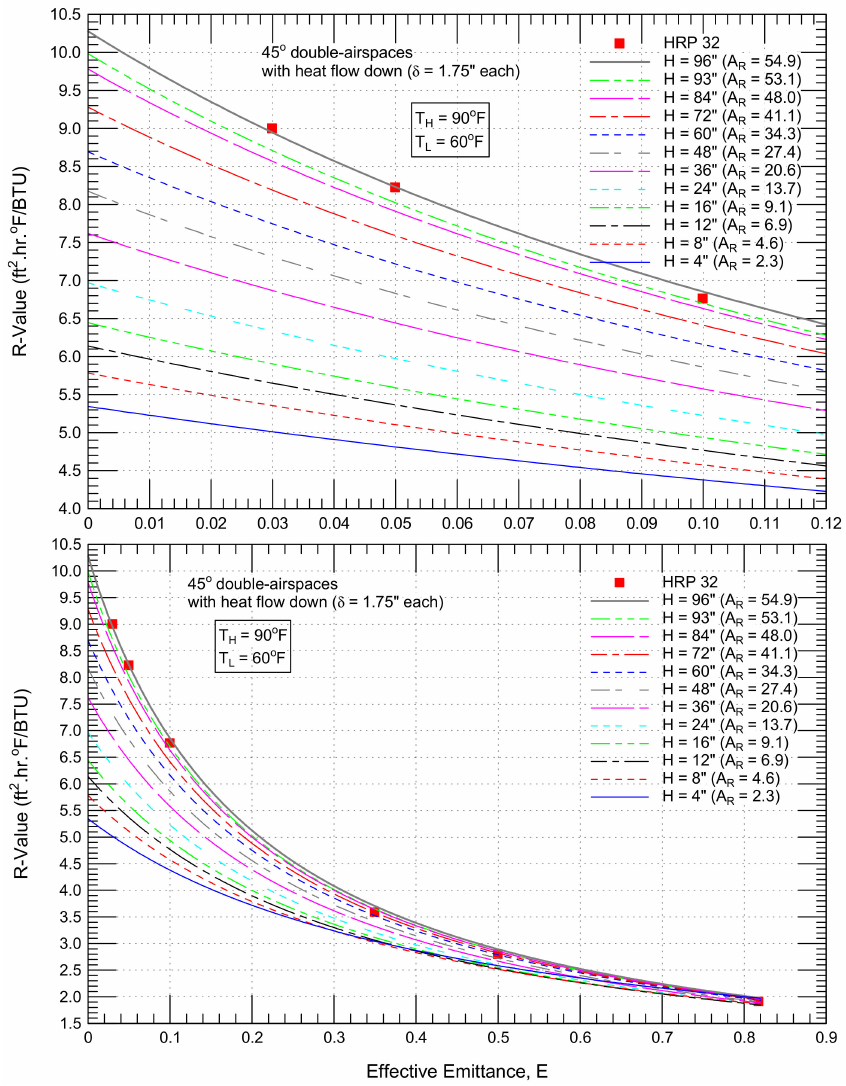
Figure 17. Comparisons of R values of HRP 32 [4] with present model predictions of various A R for sloped double airspaces subjected to a downward heat flow ( θ = 45 ◦ , total δ = 3.5 inches, T H = 90 ◦ F, T L = 60 ◦